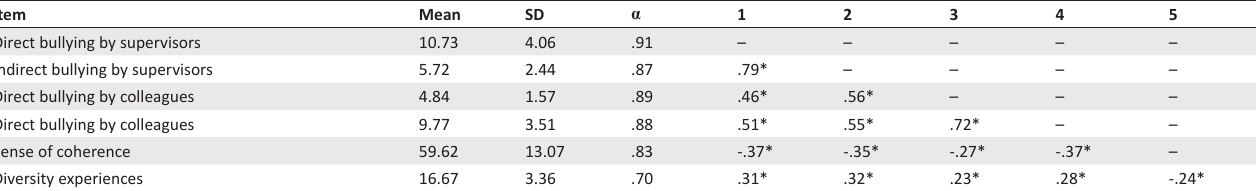
TABLE 2: Descriptive statistics, Cronbach’s alpha coefficients and correlations of the South African Employee Health and Wellness Survey. Item Mean